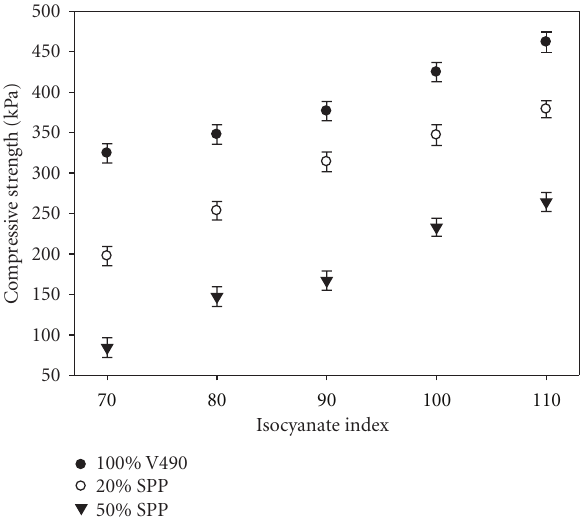
Figure 7: E ff ect of di ff erent isocyanate index on compressive strength of rigid PU foams with di ff erent SPP percentages.